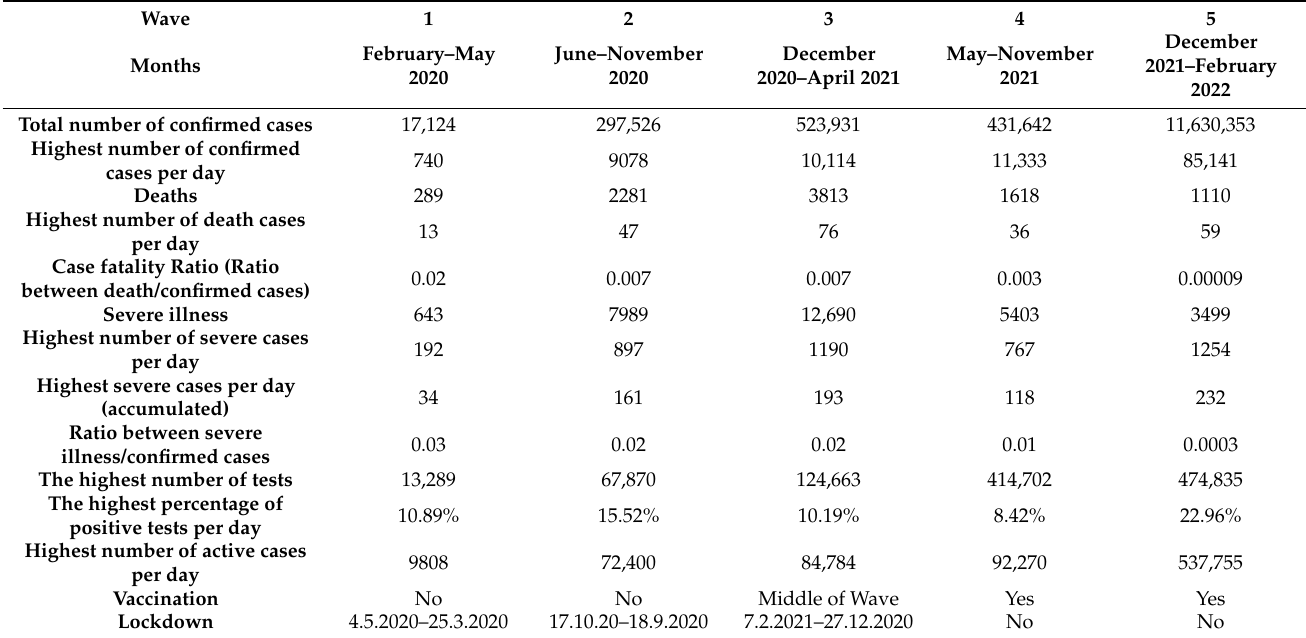
Table 1. Overall snapshot of epidemiological data on COVID-19 cases in Israel through five waves of the